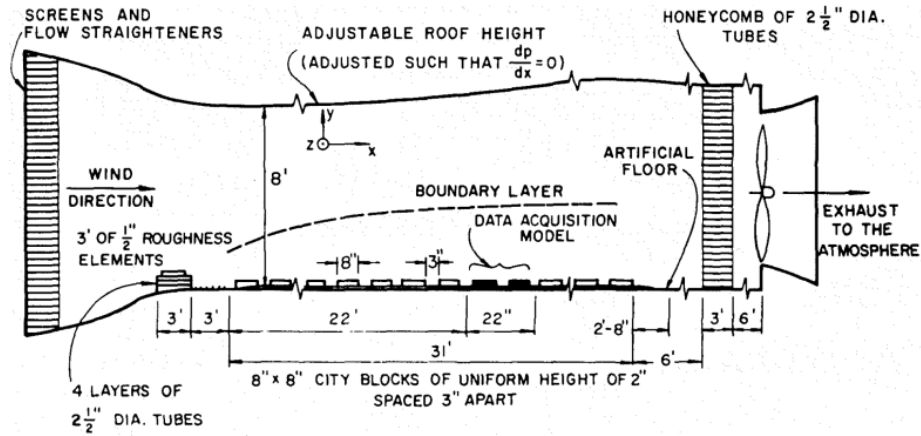
Figure 1. Schematic diagram of a typical wind tunnel experiment [9].